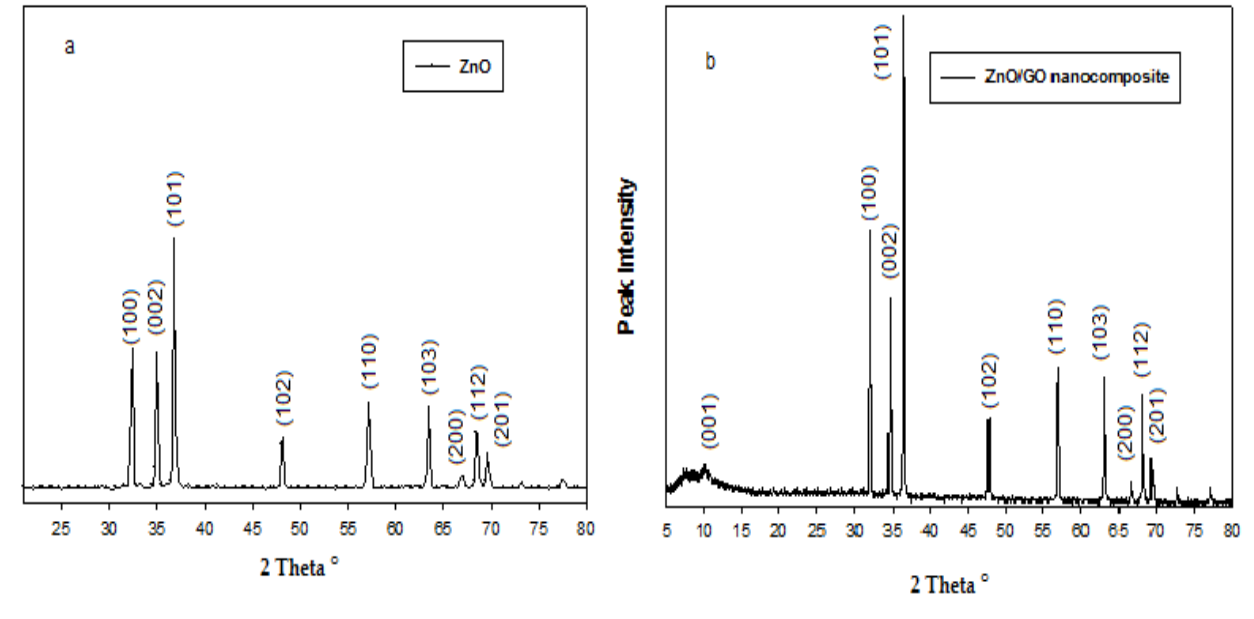
Figure 3. XRD patterns of ZnO ( a ) and ZnO/GO ( b ).